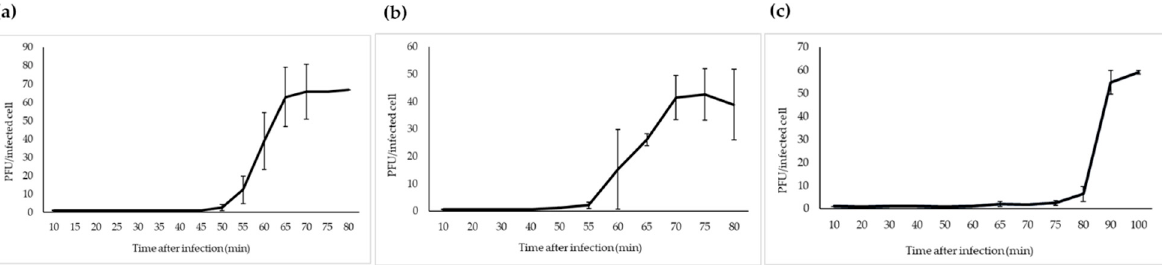
Figure 4. One-step growth curves of fPS-phages in Y. pseudotuberculosis O.1a strain PB1: ( a ) fPS-2; ( b ) fPS-65; ( c ) fPS-90. Error bars represent standard deviations (SD).